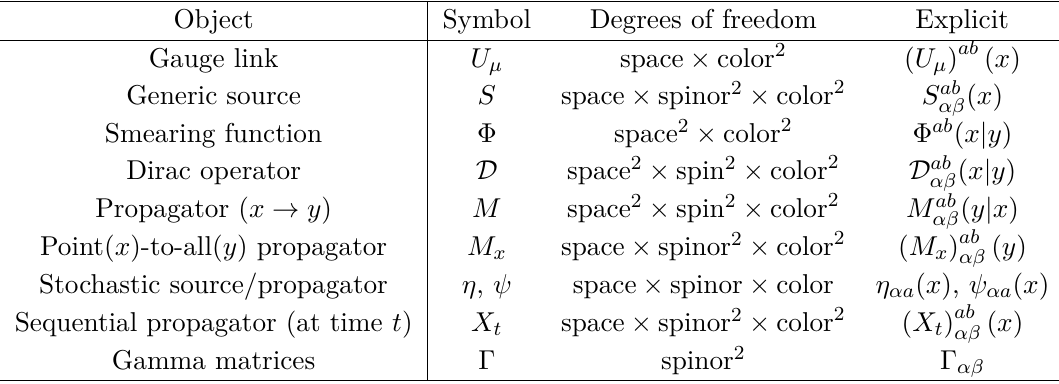
Table 15 . Lattice objects and their degrees of freedom regarding spacetime (for brevity, we write “space” in the table), spinor and color indices. Notice that Lorentz indices, e.g. of the gauge link U µ , are always written